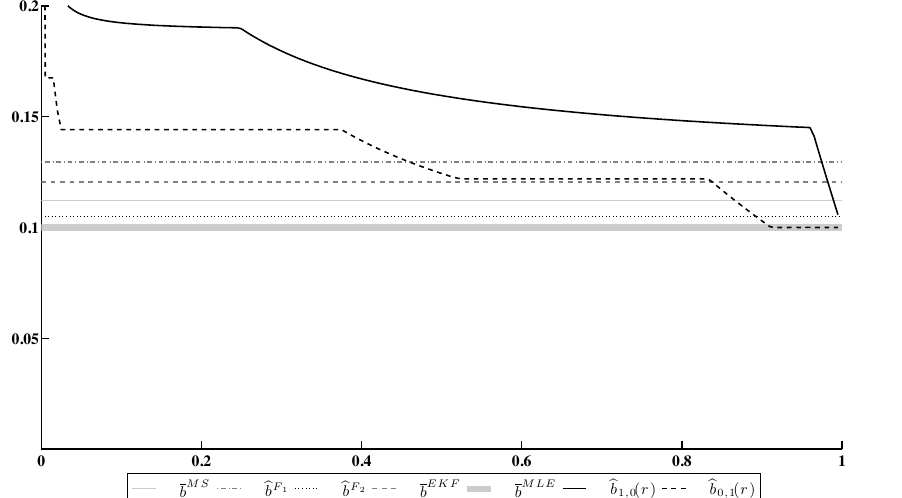
Figure 2. Estimation of the diffusion coefficient b